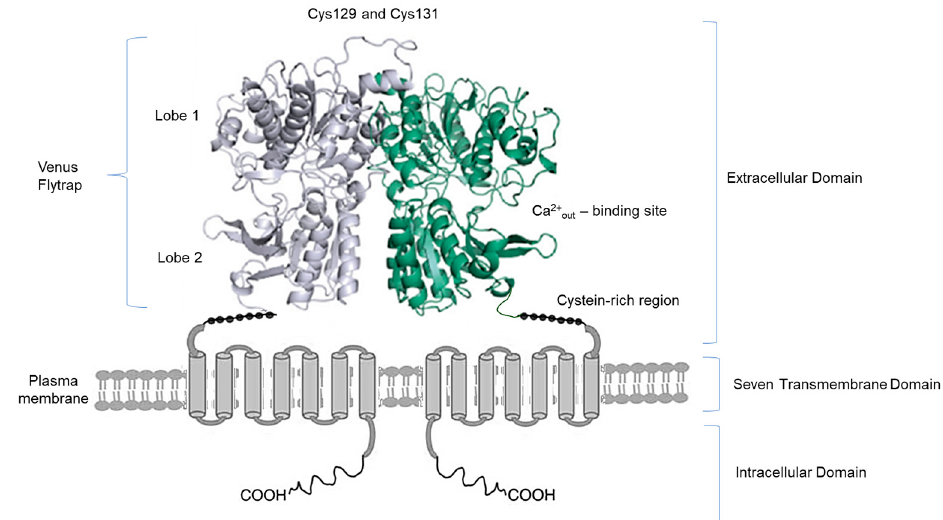
Figure 1. Schematic representation of the dimeric CaSR. Schematic representation of the CaSR homodimer structure at the plasma membrane, showing intracellular, transmembrane and extracellular domains, and Ca 2+ binding site.